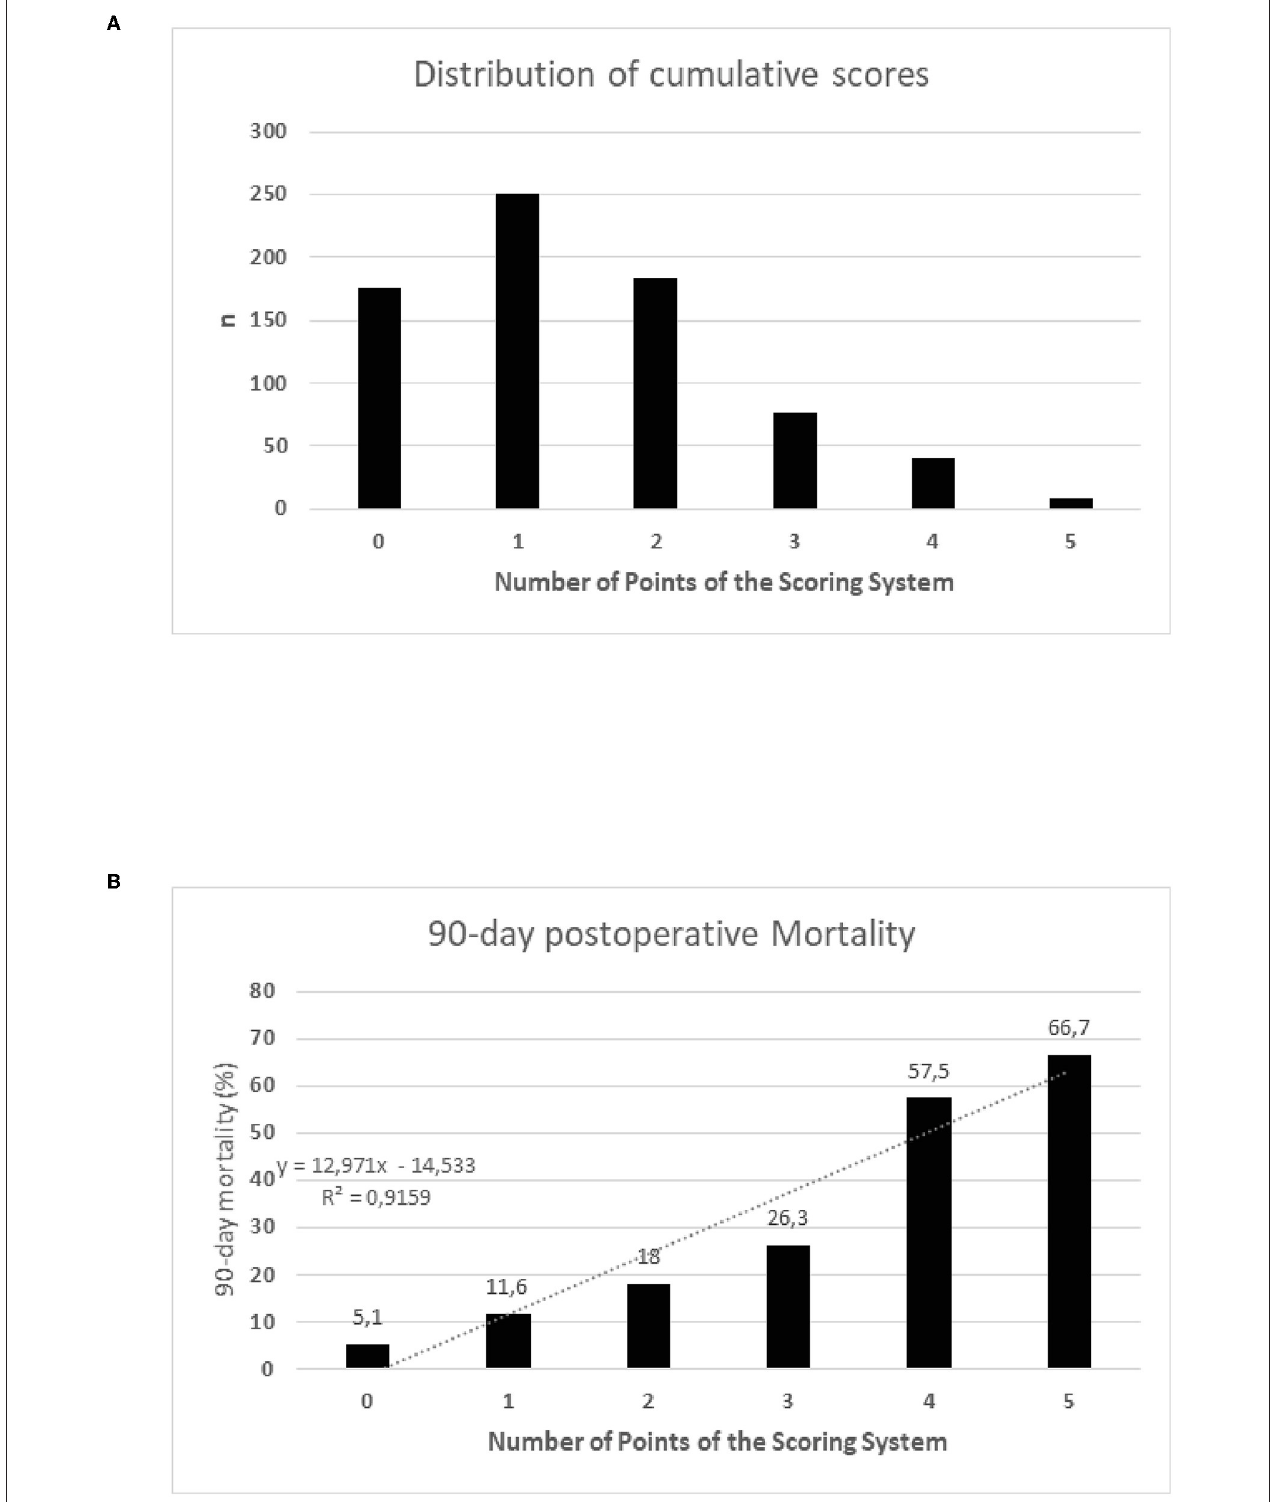
FIGURE 2 | (A) Distribution of the cumulative Molinari scores. (B) Observed 90-day mortality stratified by the cumulative points of the scoring system. Mortality significantly differed between all groups ( p = 0.001). Group comparisons demonstrated a significant increase of mortality based on cumulative scores (0 points vs. 1 point, p = 0.04; 1 point vs. 2 points, p = 0.06; 2 points vs. 3 points, p = 0.49; 3 points vs. 4 points, p = 0.01; 4 points vs. 5 points, p = 0.59).